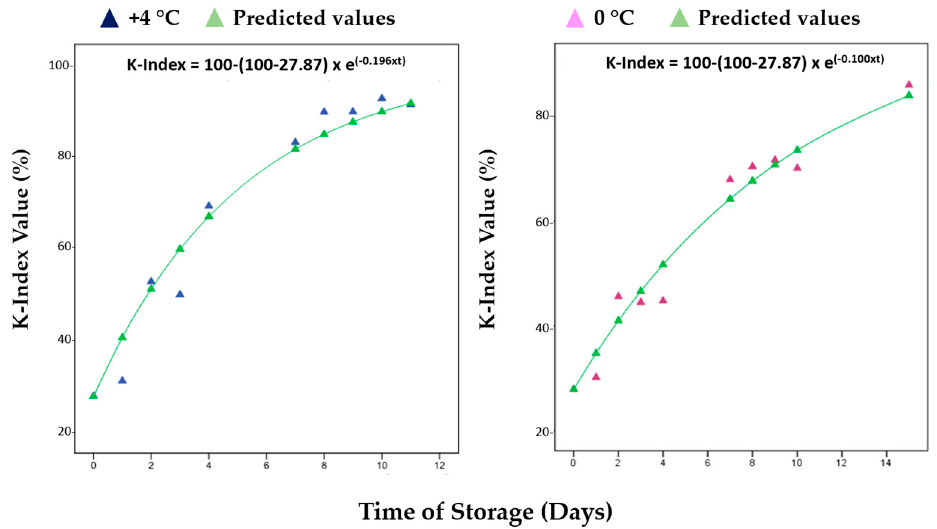
Figure 4. Fitted models of K-index (%) for red mullets ( Mullus barbatus ) during the storage at both +4 °C and 0 °C. All the percentages were calculated via NMR by using the protocol fine-tuned by Ciampa et al. [8].